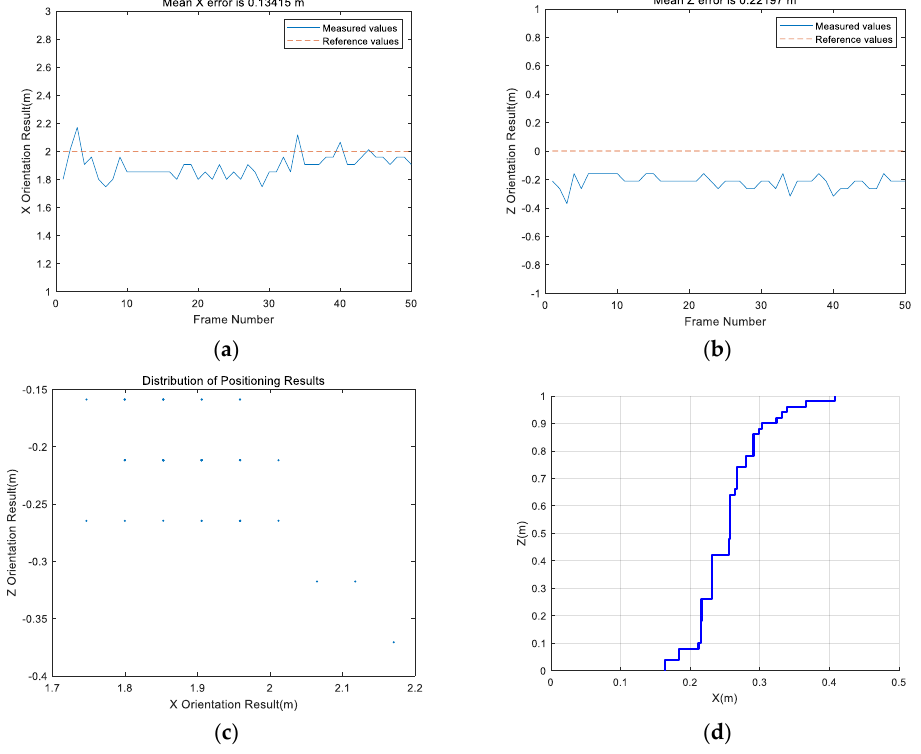
Figure 8. The static test location results for the source location of (2, 0). ( a ) Average error in the x–direction. ( b ) Average error in the z–direction. ( c ) Location distribution. ( d ) CDF.